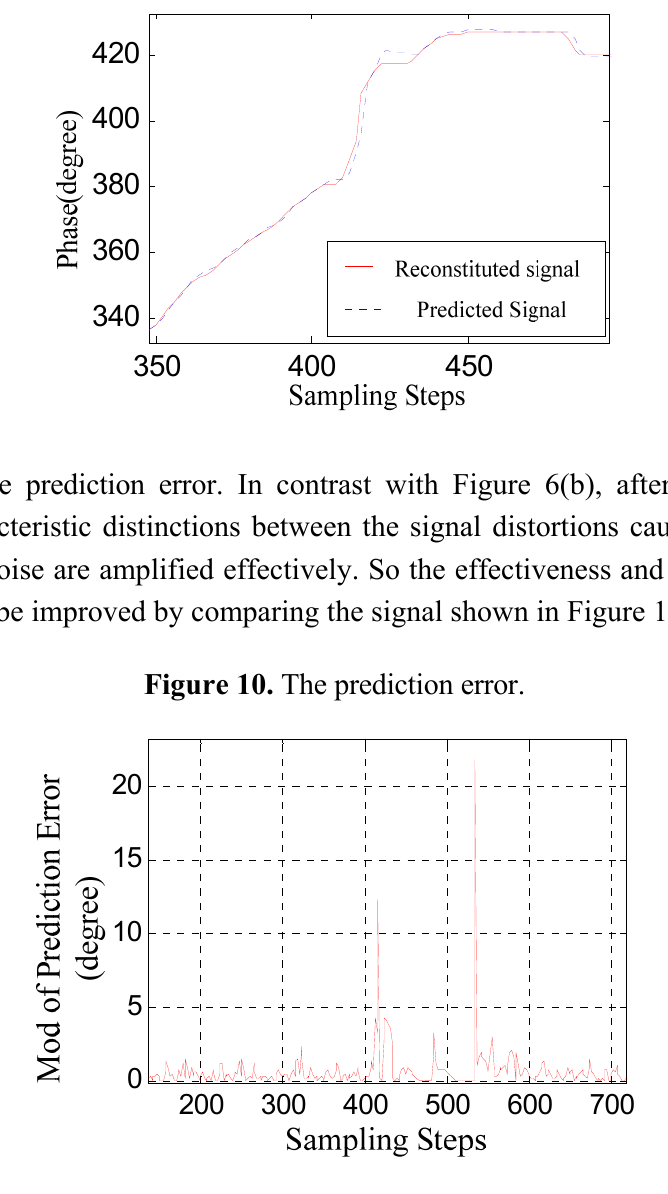
Figure 9. The reconstituted signal and predicted signal.